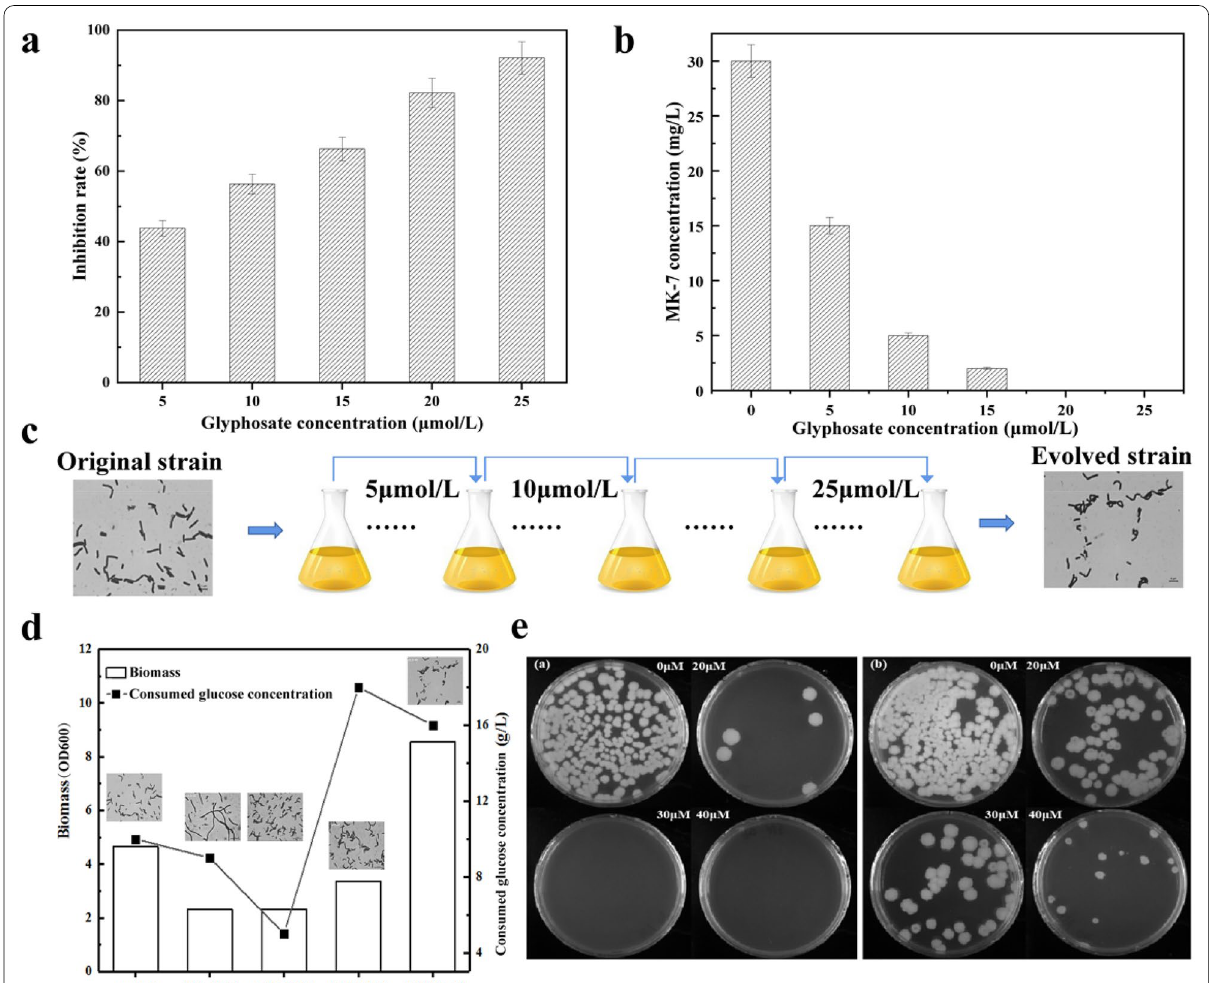
Fig. 1 Changes of cell growth properties during adaptation. Cell inhibition rates ( a ) and MK-7 concentration ( b ) at different glyphosate concentrations; ( c ) adaption experiment flow; ( d ) changes of biomass and consumed glucose concentration during adaption; ( e ) glyphosate tolerance of original strain ( e - a ) and evolved strain ( e - b